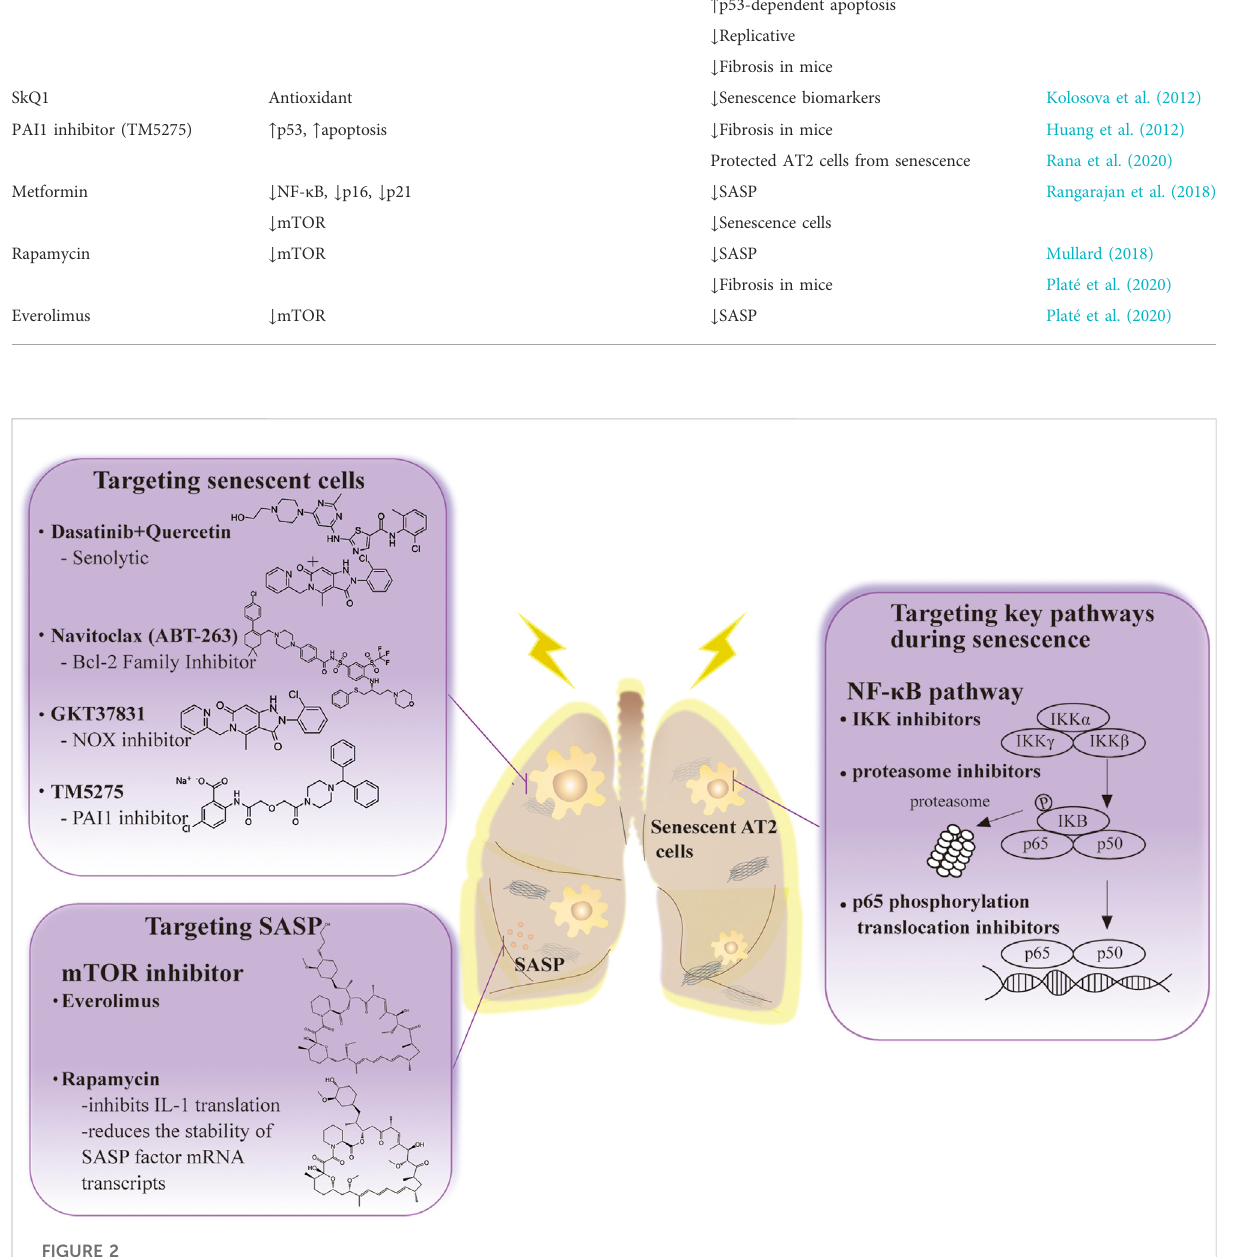
Frontiers in Cell and Developmental